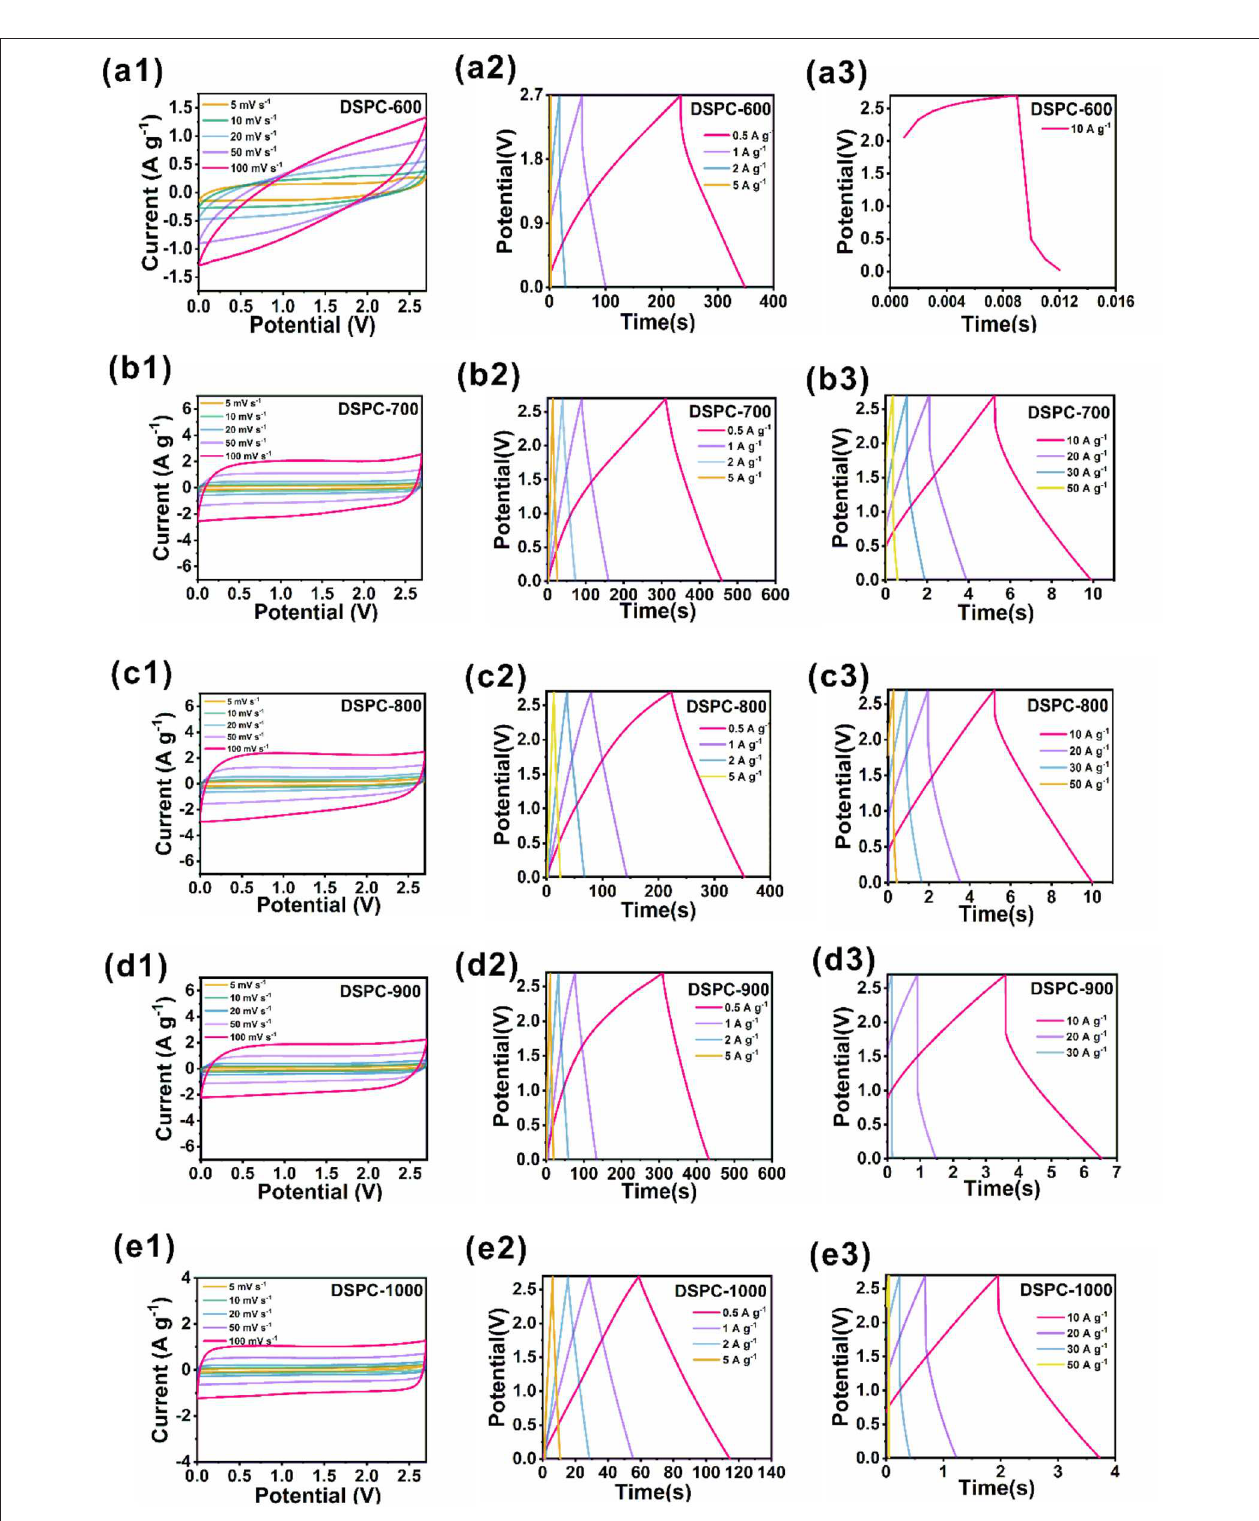
FIGURE 4 | Electrochemical performances of DSPCs. (a1–e1) CV curves at two electrode system in organic electrolyte, (a2–e2) charge/discharge curves at two electrode system in organic electrolyte, (a3–e3) charge/discharge curves at two electrode system tested in large current in organic electrolyte.